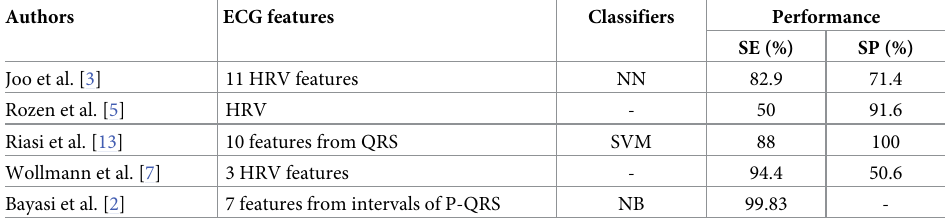
Table 7. List of prediction studies for imminent